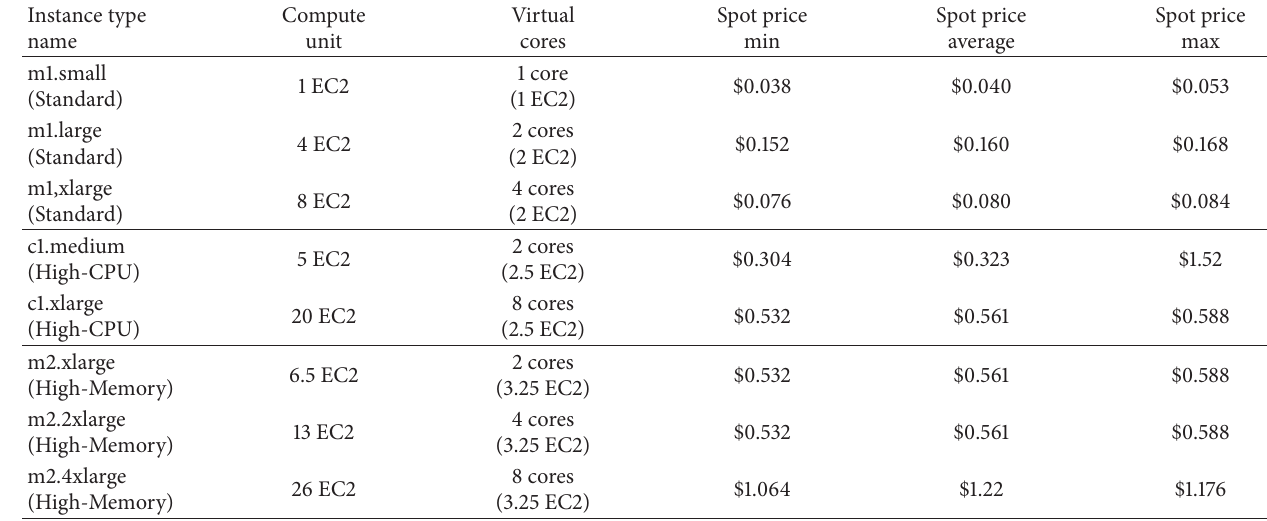
Table 1: Information of resource types.